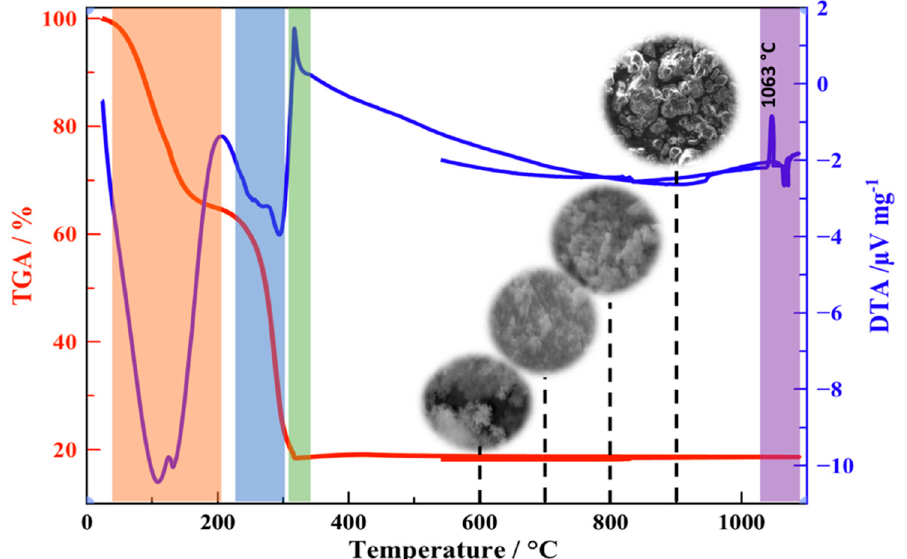
Figure 5. TGA − DTA of the white gel obtained after the coprecipitation method.